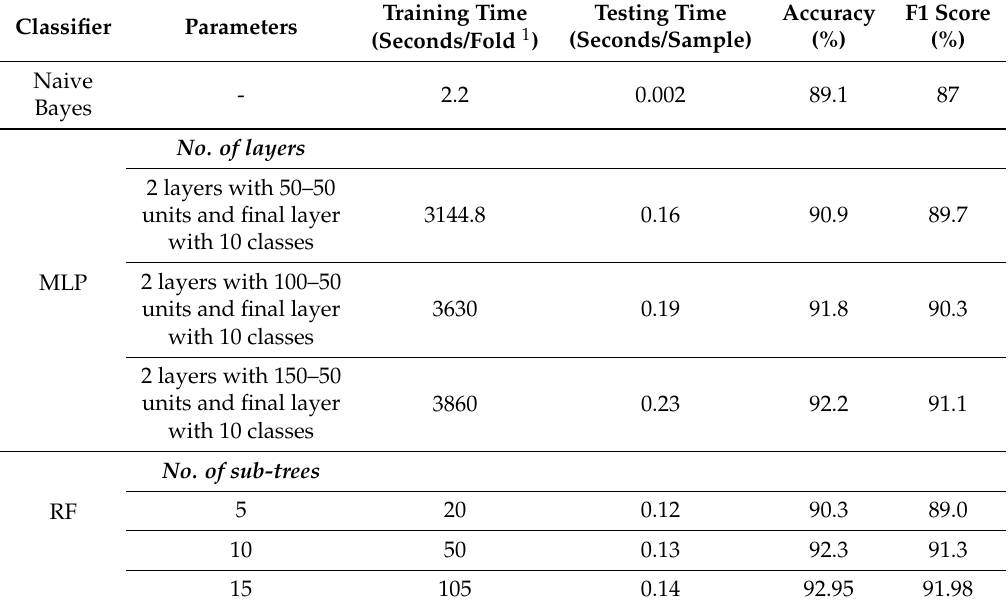
Table 1. Overall comparison of the performances, in training time and in classification accuracy, from different types of classifiers on the glove’s IMU data, by training on the data from 56 participants and testing it on the remaining 57th participant. Based on these results from this cross-validation study, the Random Forest (RF) classifier with 15 sub-trees was chosen as it gave the highest accuracy (92.95%) for a negligible training time (105 s per fold 1